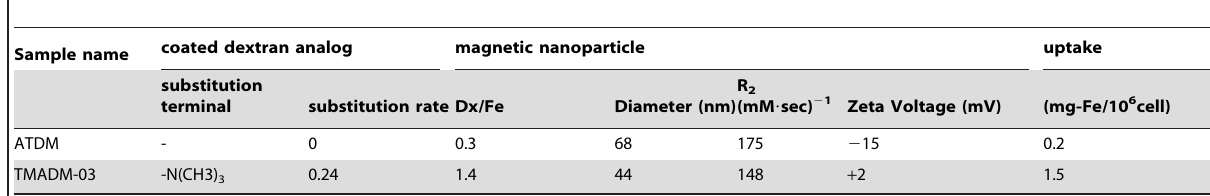
Table 1. Characterization of magnetic nanoparticles.